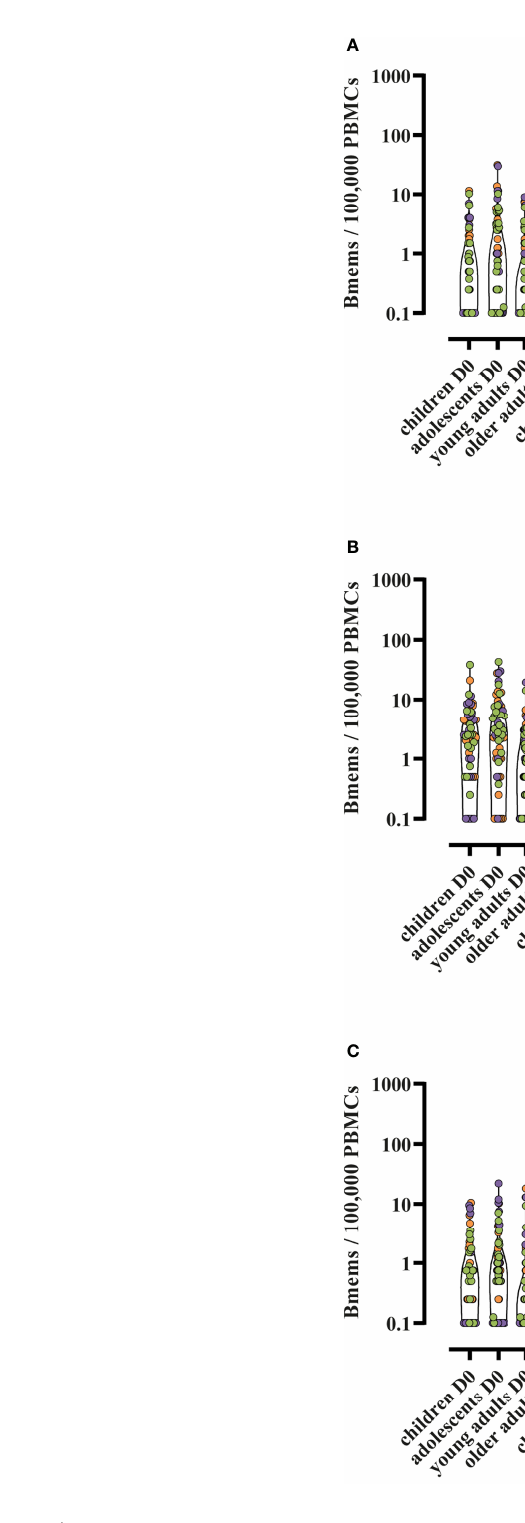
FIGURE 2 | Individual memory B cell frequencies in four age groups. Bmems, memory B cell frequencies; PBMCs, peripheral blood mononuclear cells; D0, day 0 (baseline); D28, day 28 post-vaccination; Y1, 1 year post-vaccination. Memory B cell frequencies speci fi c for (A) pertussis toxin; (B) fi lamentous haemagglutinin; and (C) pertactin. Presented in truncated violin plots. Corresponding geometric mean frequencies and 95% con fi dence interval are presented in Table 2